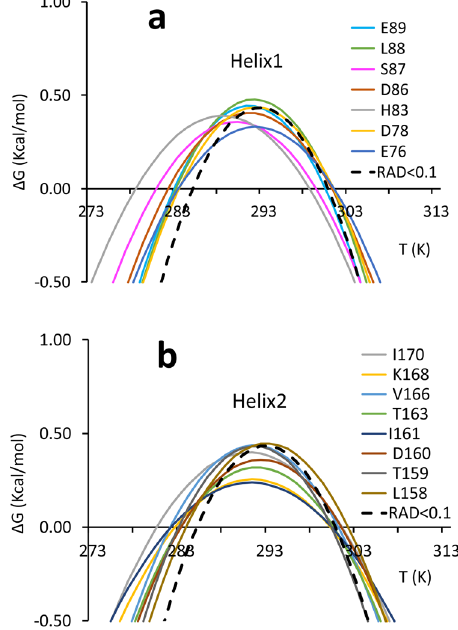
Fig. 4 Stability curves of residues belonging to secondary structure elements. a Helix 1. b Helix 2. Residues are labelled with a single letter code. The average stability curve is shown as a black dashed line.